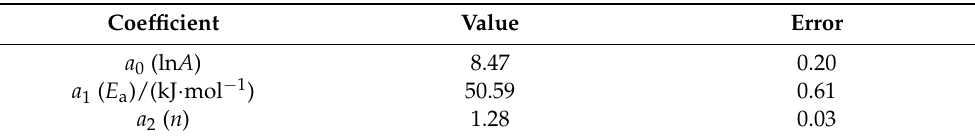
Table 1. Estimated coefficients a 0 , a 1 , and a 2 of the model represented by Equation (6) for bulk polymerizations ranging from 90 to 130 ◦